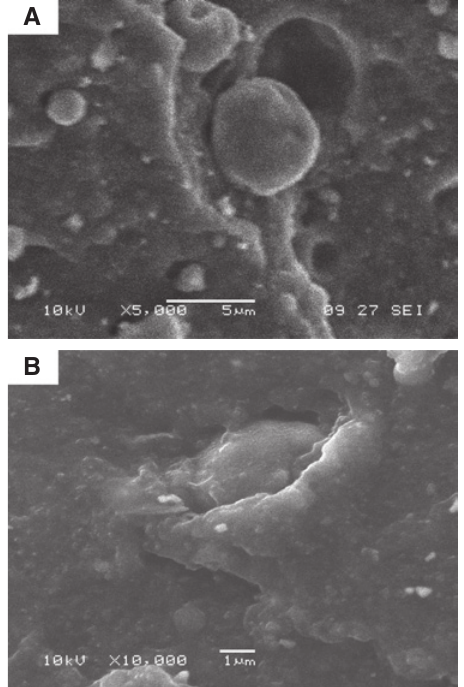
Figure 6 SEM images of the fracture surfaces of the zeolite/rubber composites: (A) with 8/42 the unmodified zeolite/CB and (B) with 8/42 the modified